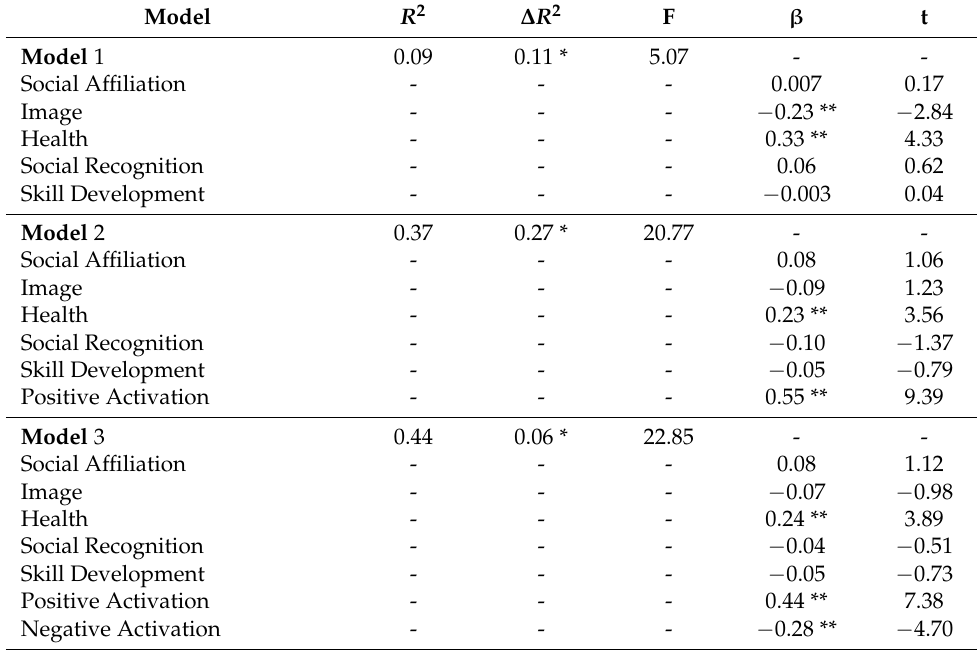
Table 2. Standardized beta coefficients and explained